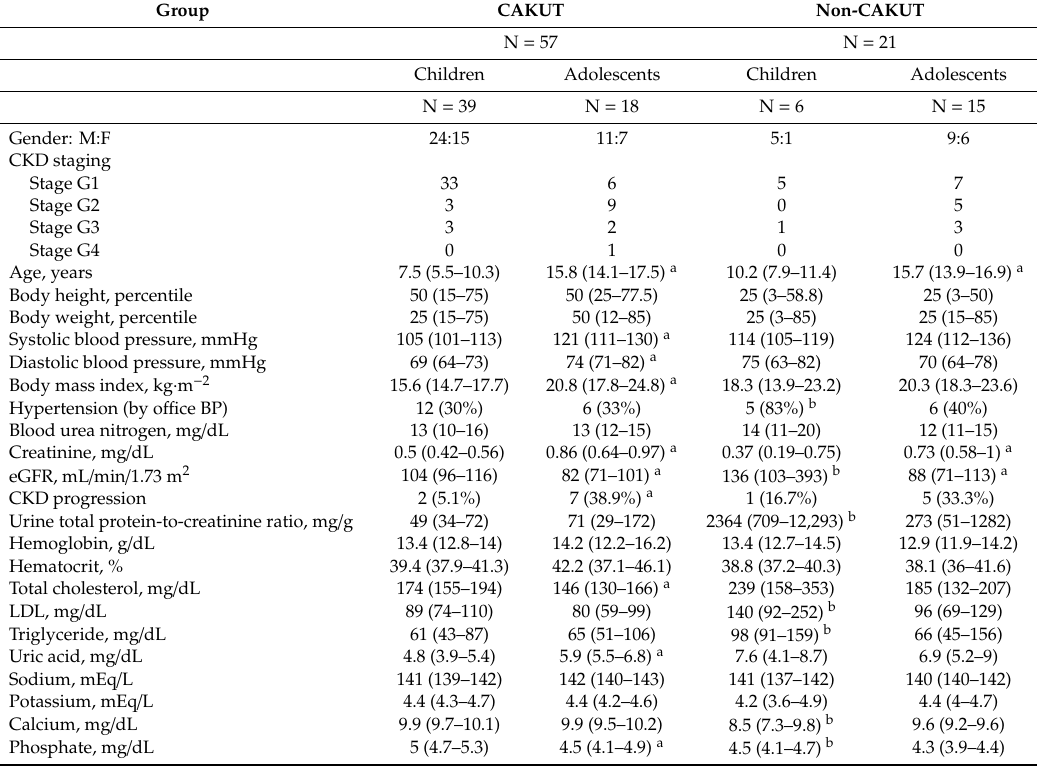
Table 1. Clinical, anthropometric and biomedical characteristics in children and adolescents with chronic kidney disease (CKD).